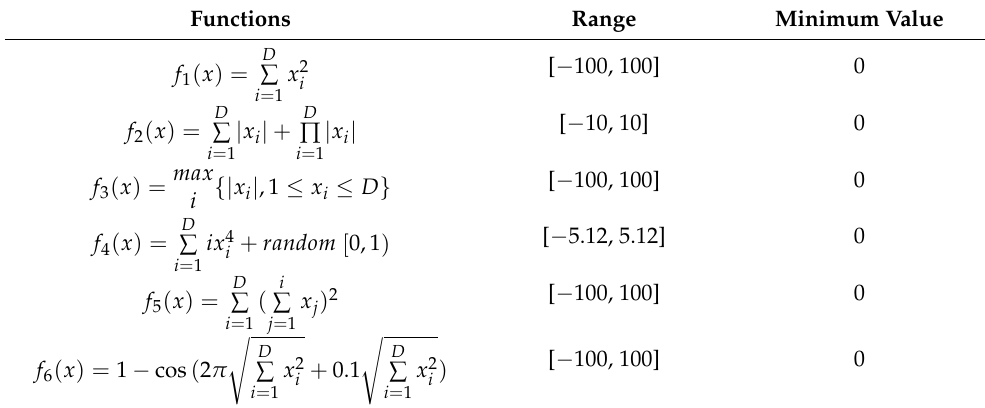
Table 11. Benchmarking